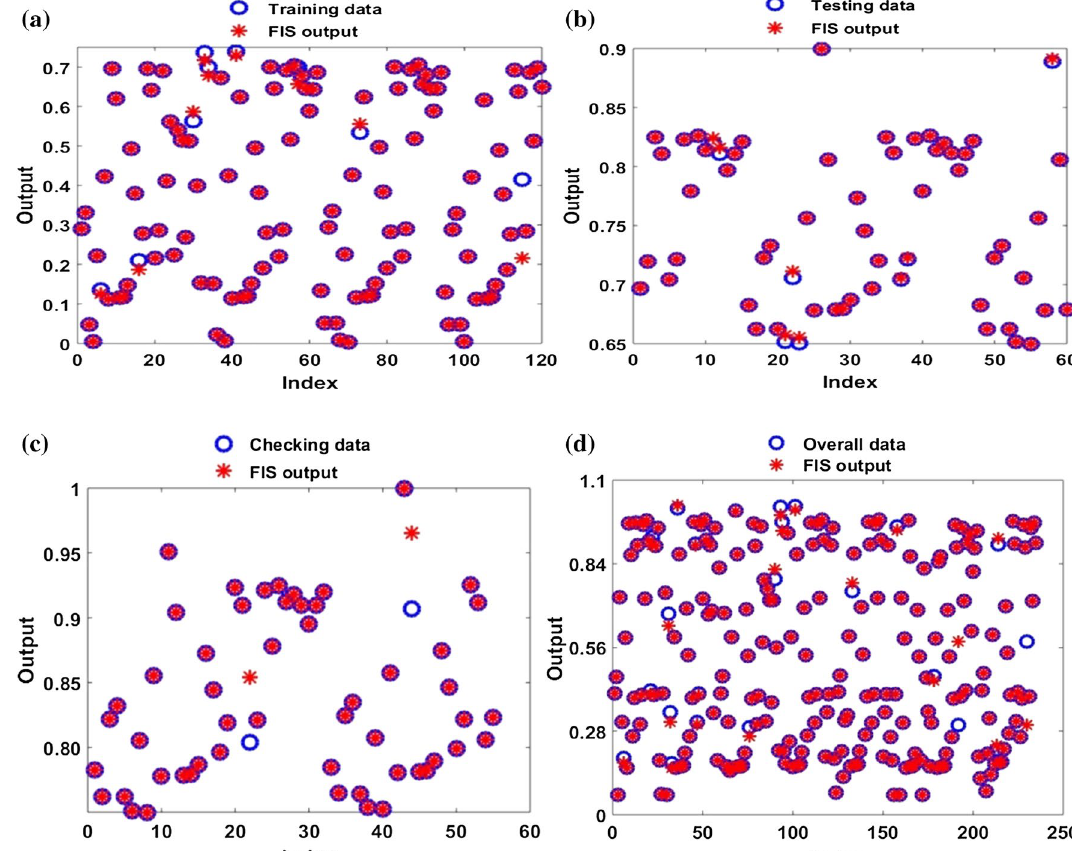
Fig. 6 ANFIS plots for a training data, b testing data, c checking data, and d overall data